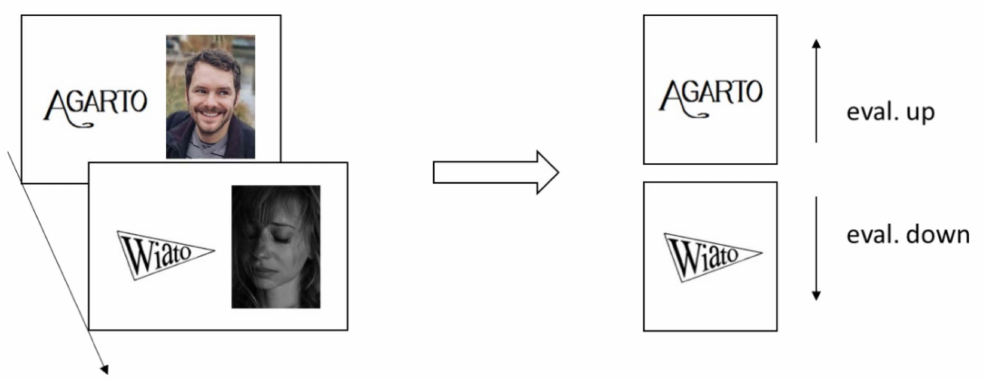
Figure 1. Illustration of a prototypical pairing procedure using (artificial) brand names as target stimuli, and positive and negative images as source stimuli [42]. The repeated pairings of target and source stimuli typically lead to changes in the evaluation of the targets. Targets paired with positive sources are evaluated more favorably than targets paired with negative